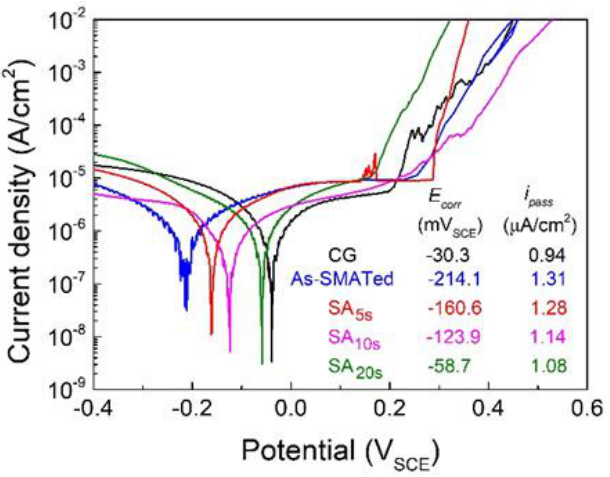
Figure 6. Potentiodynamic polarization curves of as-SMATed and SA x s gradient samples. The curve of homogeneous coarse-grains is also plotted for comparison. The value of E corr and i pass are averaged from three independent tests.